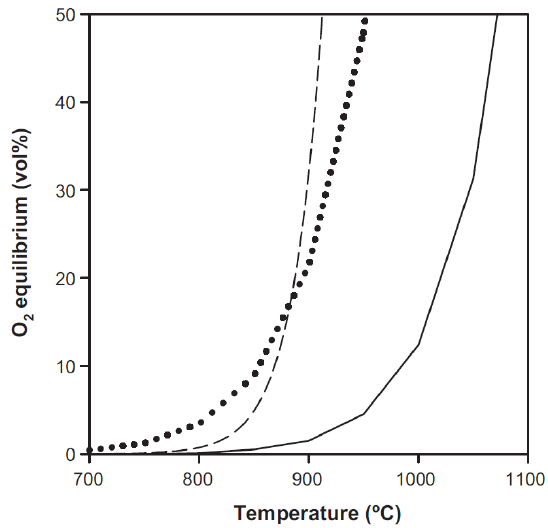
Figure 8. Equilibrium oxygen concentrations of CuO/Cu 2 O ( ― ), Mn 2 O 3 /Mn 3 O 4 (• •), and Co 3 O 4 /CoO ( - -) as a function of temperature